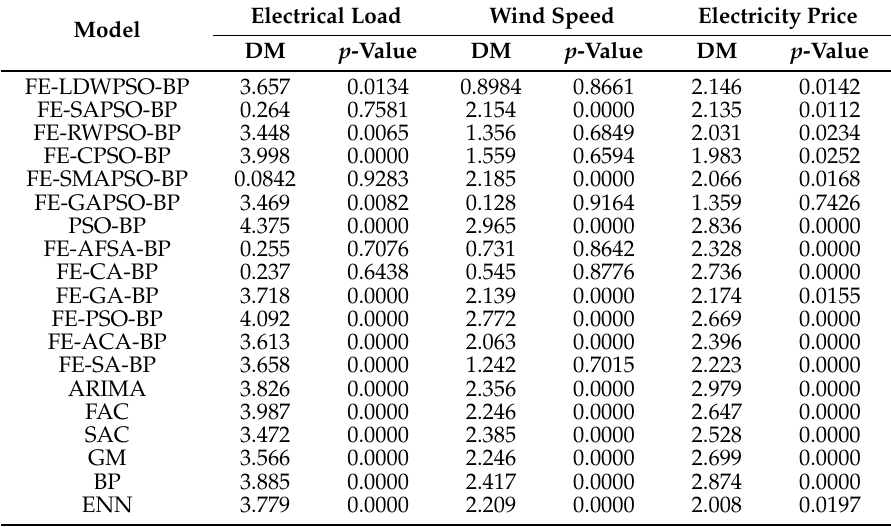
Table 6. Summary of DM test (values of DM are absolute